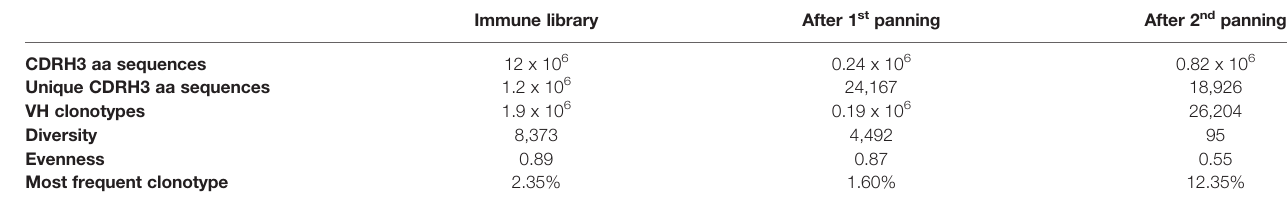
TABLE 1 | Summary of sequencing analyses of the immune library during